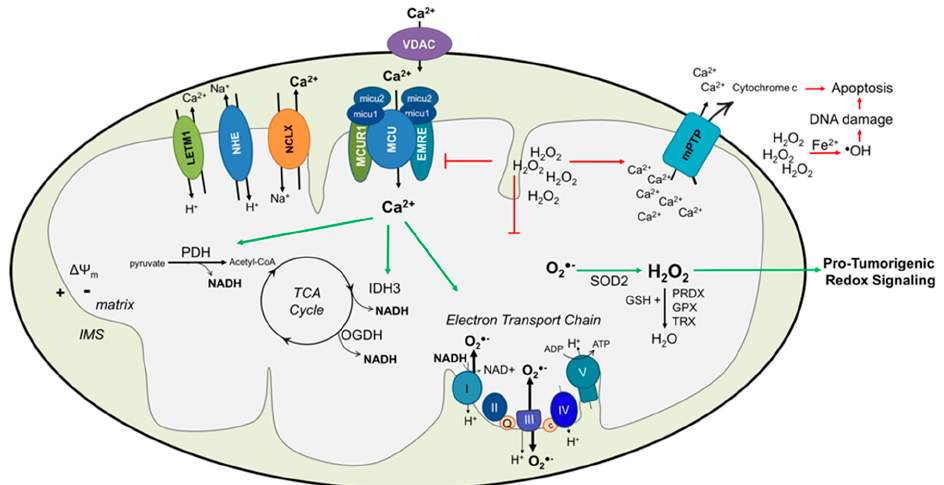
Figure 1. Cancer cells alter mitochondrial Ca 2+ dynamics to enhance pro-tumorigenic mROS signaling (green arrows). Altered expression or post-translational regulation of proteins involved